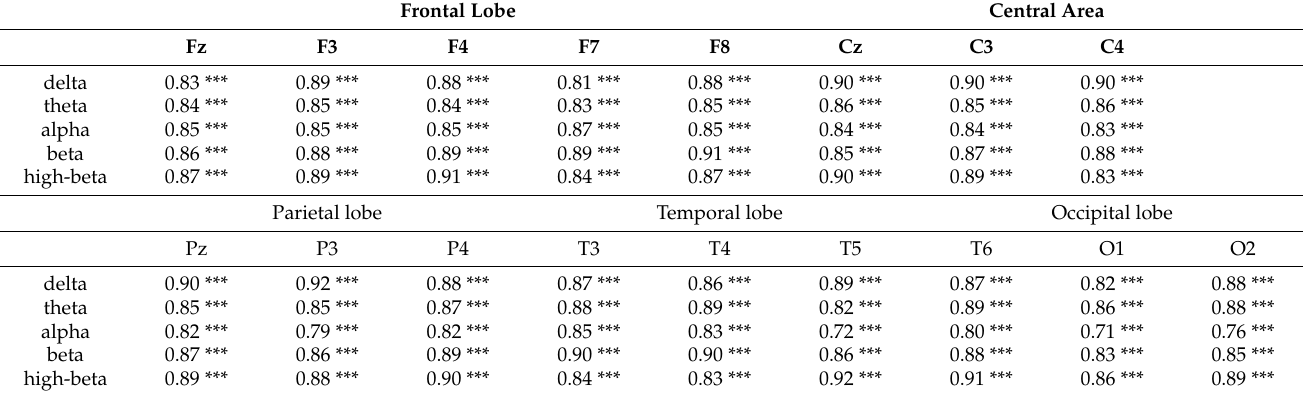
Table 3. The Pearson’s correlations of z -scores between the Taiwan and NeuroGuide databases.